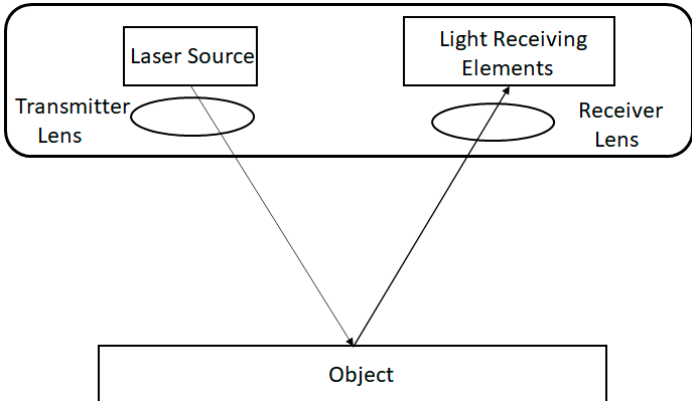
Figure 1. Working principle of a laser-based sensor.